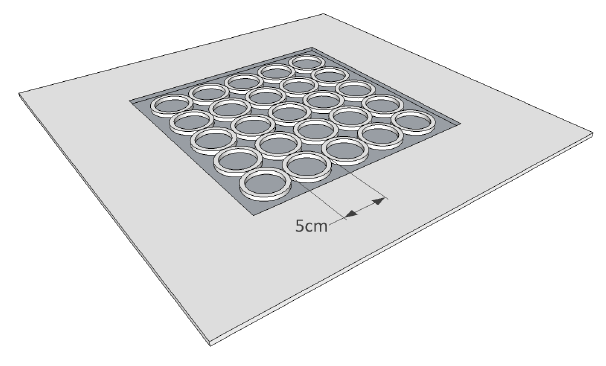
Fig.1: The sensor design based on a 5 by 5 planar coil